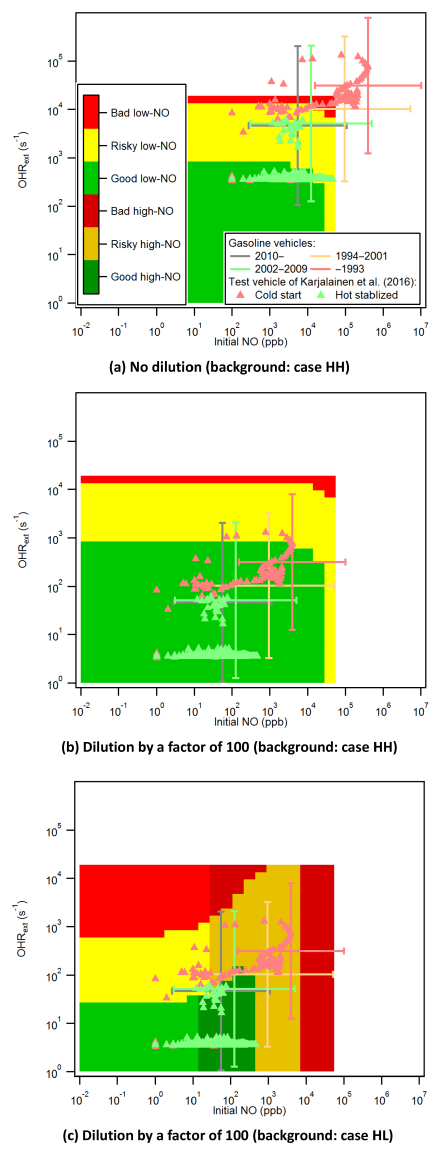
Figure 9. Location of individual 1s data points vs. OFR185-iNO reaction conditions. Data points are shown from the test vehicle of Karjalainen et al. (2016) and average exhaust from gasoline vehicle on-road emissions measured by Bishop and Stedman (2013). On- road emissions are classified by vehicle year and the distribution of each category is shown as a cross representing 1SD (standard deviation; with lognormal distribution assumed). The x and y axes are NO and external OH reactivity (excluding N-containing species) due to vehicle emissions in an OFR in the cases of (a) no dilution and (b, c) dilution by a factor of 100. The Karjalainen et al. (2016) points are classified as cold start (during the first 200s) and hot stabilized (during 200–1000s). In addition, the same image plots as the panels of cases HH (high H 2 O and high UV; see Table 2 for the case label code) and HL in Fig. 4 (OFR185-iNO) are shown as background for